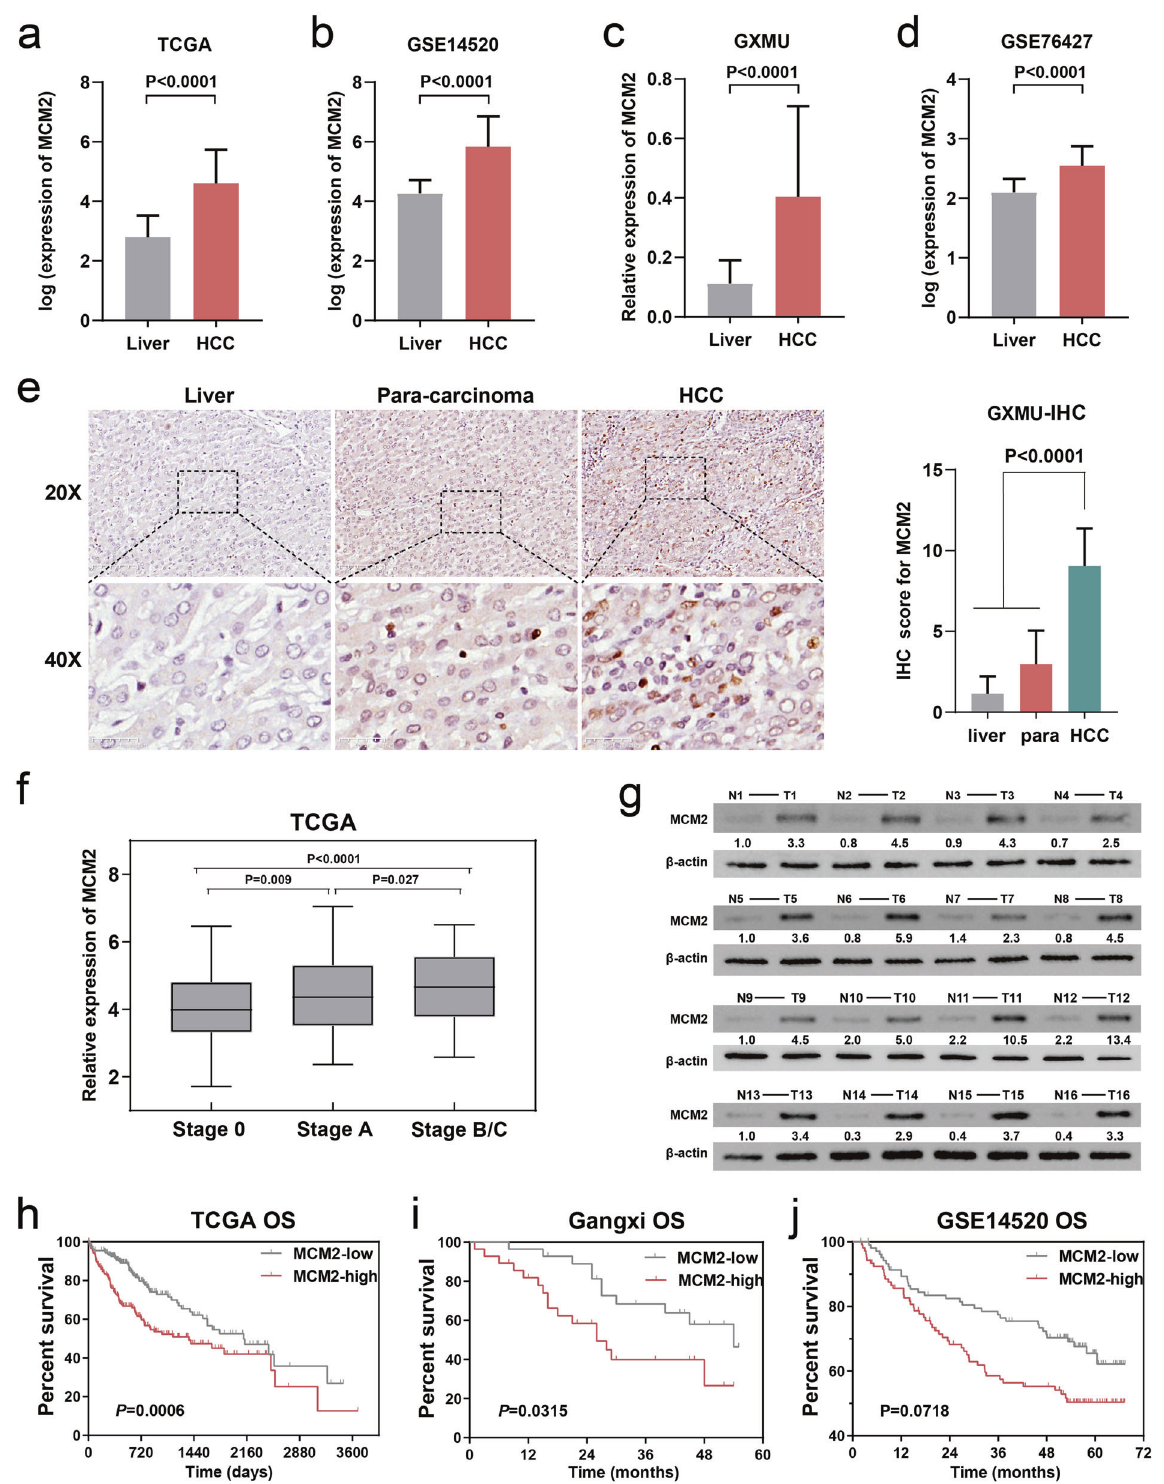
Fig. 1 MCM2 is high expressed in HCC tissues and is associated with poor prognosis. a – d Expression of MCM2 at the transcription level between HCC and normal liver tissues in TCGA LIHC dataset, GSE14520 dataset, GXMU cohort and GSE76427, and differences of MCM2 expression were statistically signi fi cant in each cohort; e Expression of MCM2 in HCC, para-carcinoma and normal liver tissues in GXMU cohort determined by immunohistochemistry assay, and the intensity of MCM2 expression was signi fi cantly higher in HCC than in para-carcinoma and liver tissue; f The expression of MCM2 in HCC patients with different BCLC stages in TCGA LIHC dataset, and patients in advanced BCLC stage were with higher expression of MCM2; g The immunoblotting for MCM2 expression of HCC tissues (T) and normal liver tissues (N) in GXMU cohort, determined by Western Blot assay; h – j Using the median MCM2 as the cut-off value, the prognosis of patients with high and low expression HCC differed signi fi cantly, with a poor prognosis for those with high MCM2.